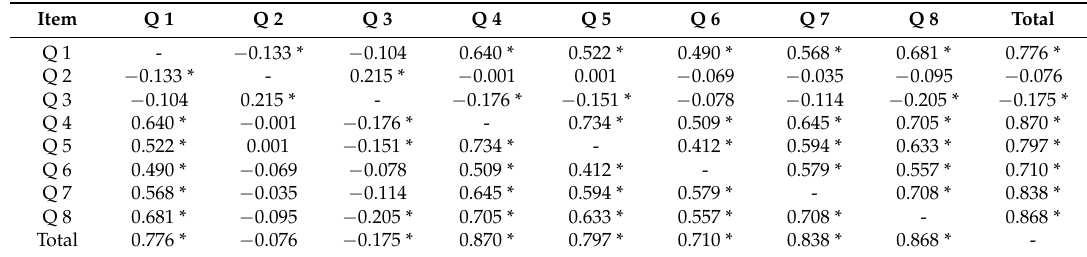
Table 2. Correlations between each question (Q 1 to 8) and the total DTSQ scores. This was modified and adopted from reference